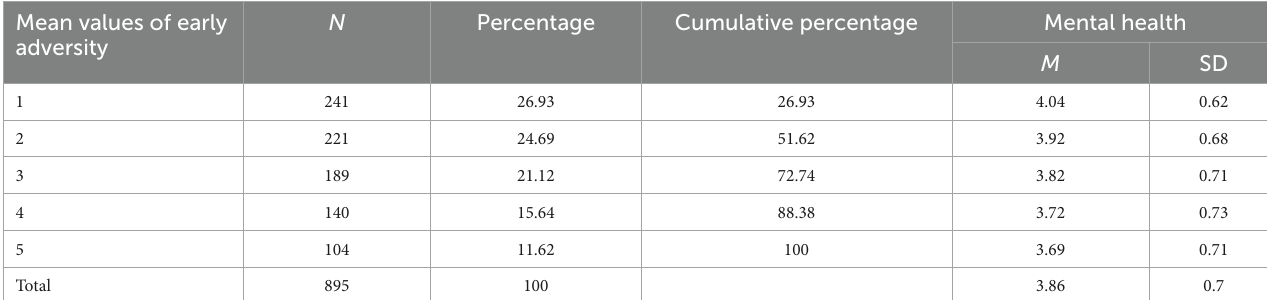
TABLE 2 Mean values of early adversity and mental health.